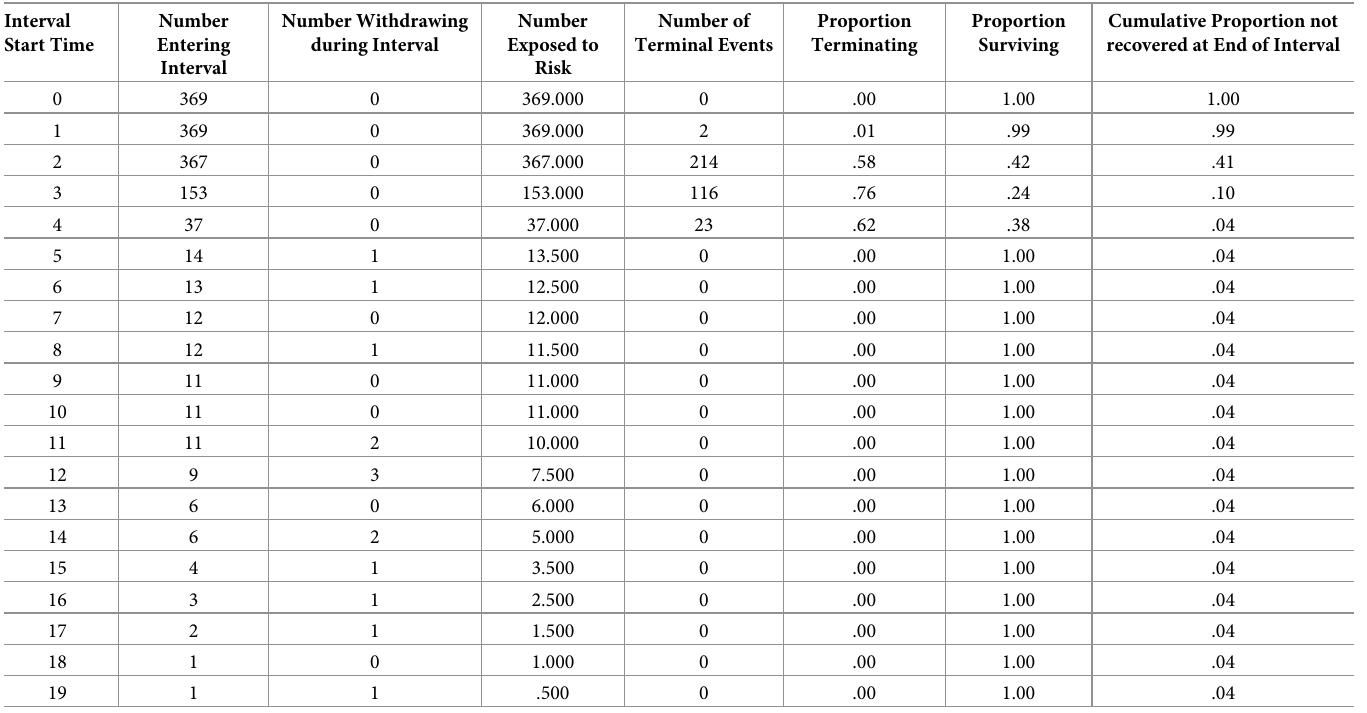
Table 4. Life table analysis of severely among women who gave birth by CS delivery at HUCSH,